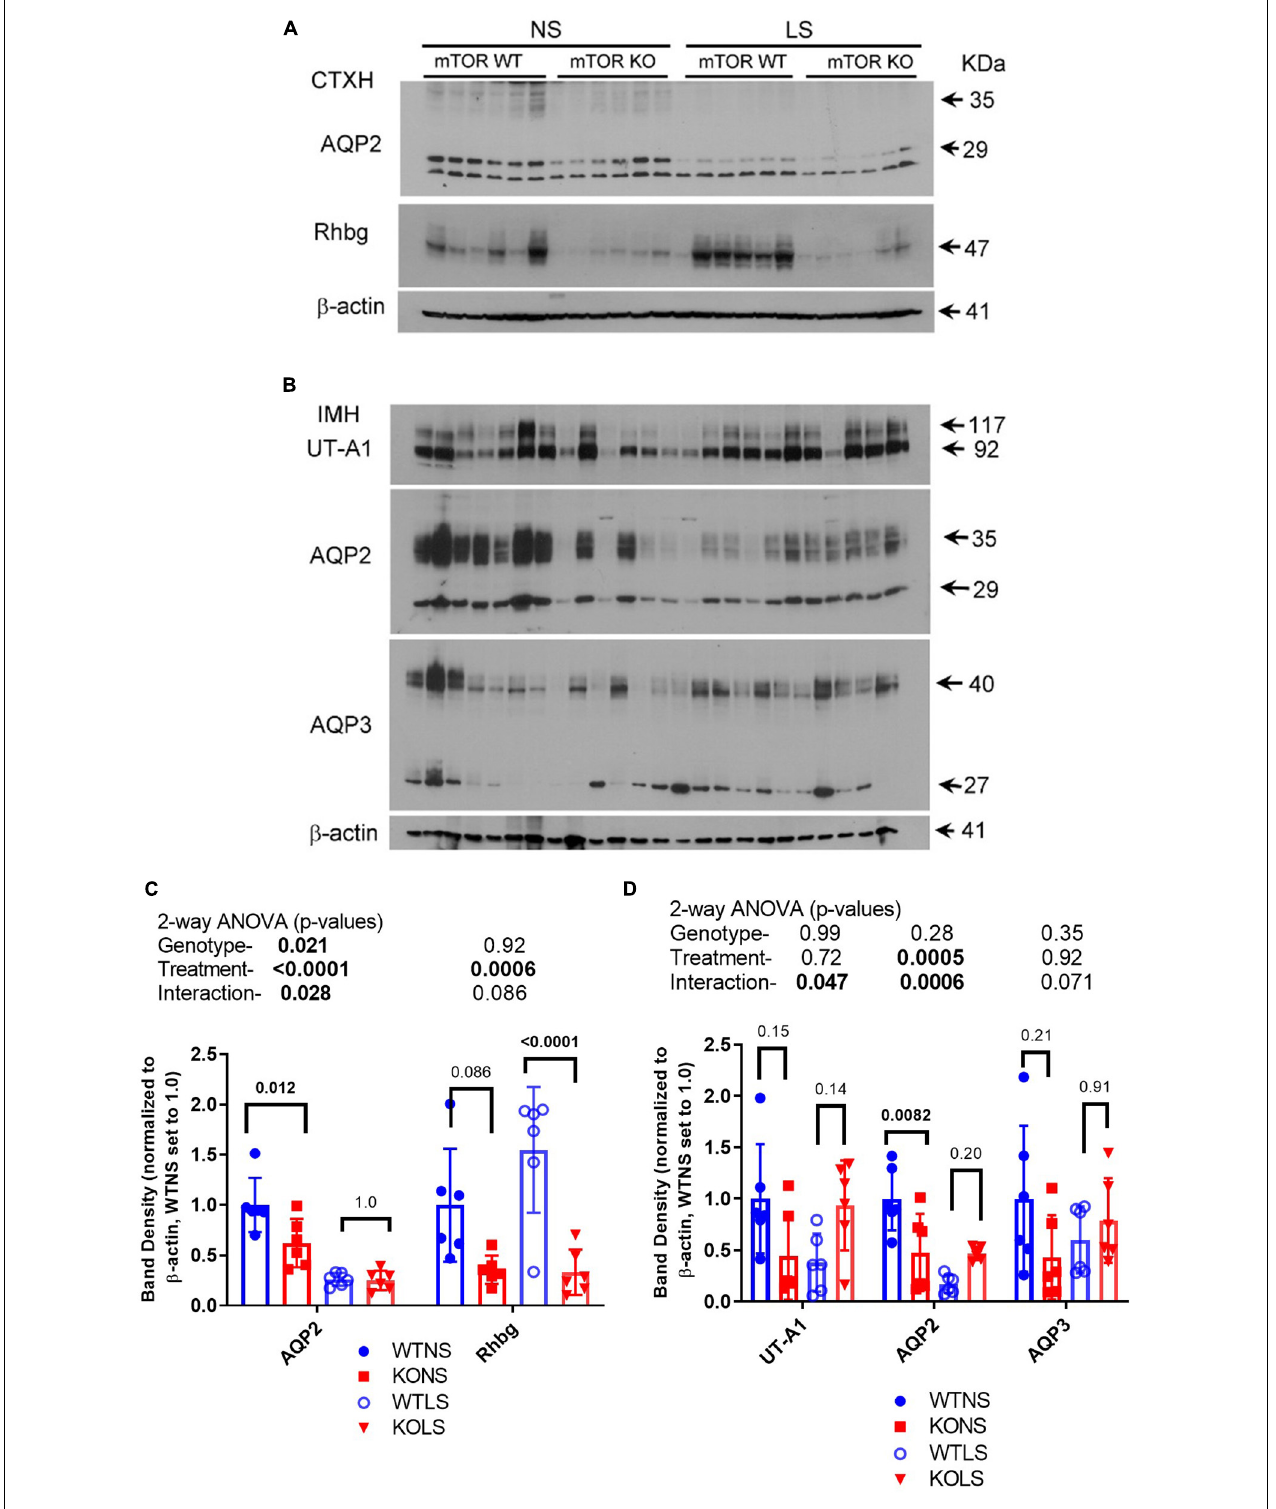
FIGURE 7 | Protein abundances of selected transport/channel proteins in collecting ducts. Western blots of kidney (A) cortex homogenates or (B) inner medullary homogenates from NS and LS diet fed male WT and KO mice were probed with antibodies against candidate proteins. (C,D) Band density (mean ± sem) summary ( n = 6 mice/treatment/genotype) and two-way ANOVA p -values for major bands. AQP2, aquaporin-2; AQP3, aquaporin-3; Rhbg, ammonium transporter; UT-A1, urea transporter. KO mice had reduced protein levels for AQP2 and Rhbg in cortex. Inner medullary protein levels were less affected by the KO.